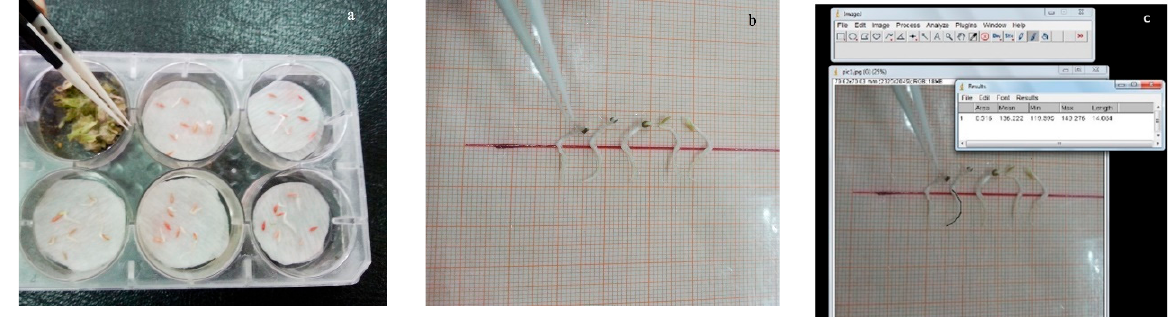
Figure 2. ( a ) Examination of germinated lettuce seeds after an incubation period, ( b ) Preparing germinated seeds on checkered paper, and ( c ) Measuring hypocotyl and radicle growth using Image J software.